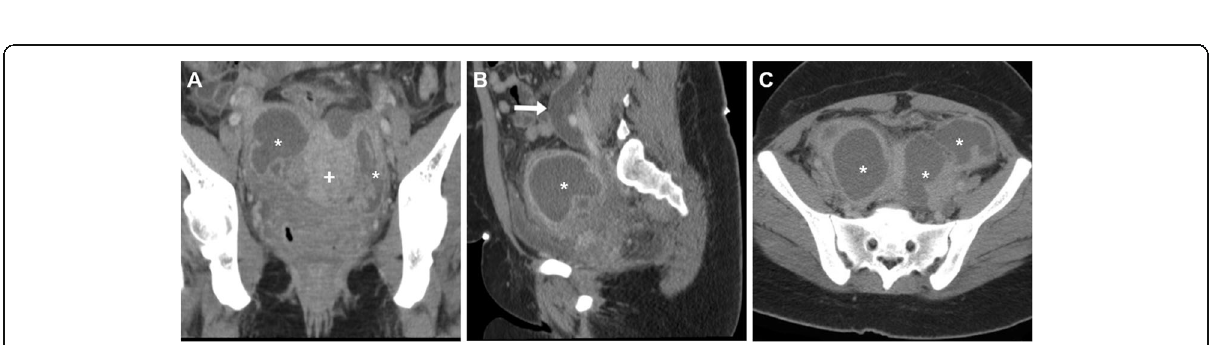
Fig. 21 a – c Multiplanar CT images of an extensive PID in a 27-year-old African woman, complicated by multiple, confluent abscesses (asterisk) occupying the entire pelvis, that compress the uterus (plus sing) on the midline. Note hydronephrosis (arrow in b ). Clinical and radiological suspicion of actinomycosis was not supported by microbiology